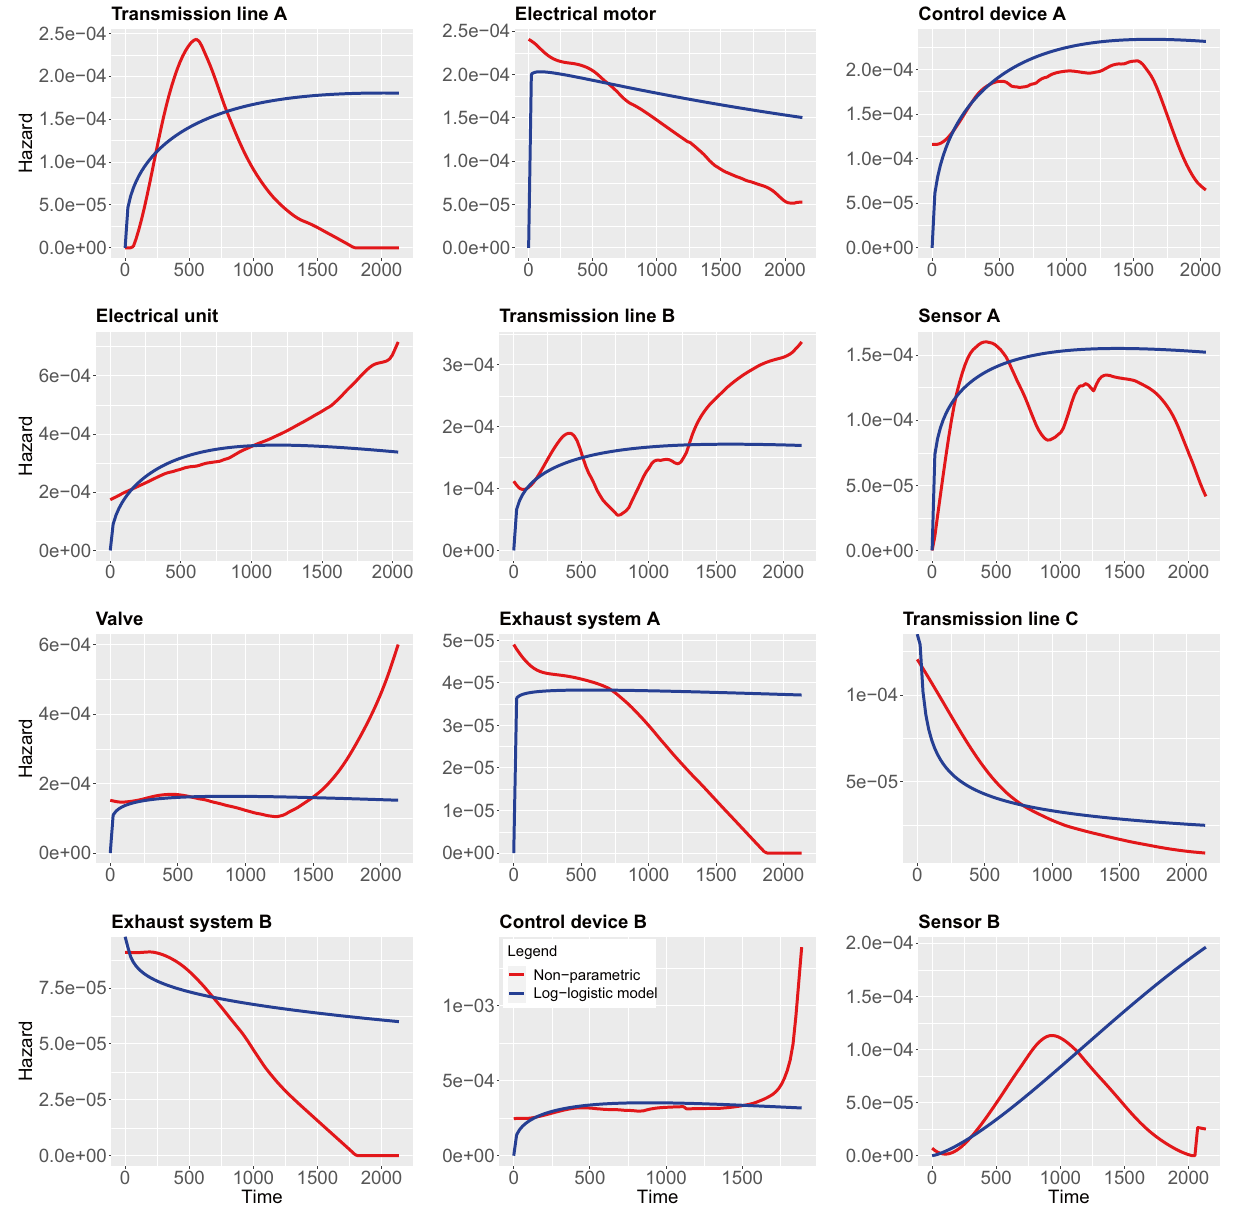
Figure 9. Log-logistic model hazard. Blue curve indicates Log-logistic model hazard and red curve represents non-parametric kernel-estimator